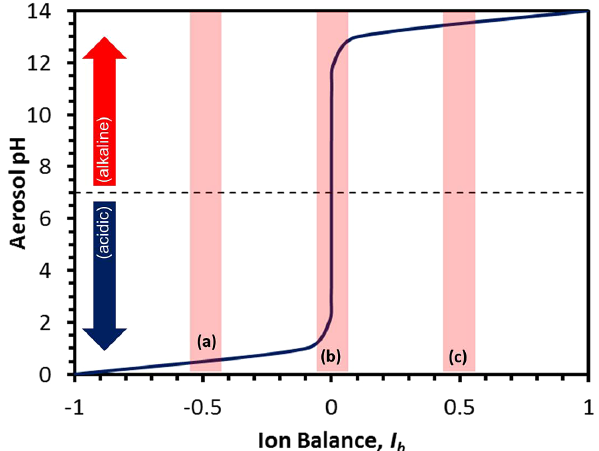
Figure 2. Aerosol pH as a function of the parameter I b (see Eq. 7 for explanation). The data used here are hypothetical: values of I b ranging from − 1 to 1 at a constant aerosol loading were input un- der conditions of constant T and RH to demonstrate the extreme sensitivity of aerosol pH at I b values near 0.0 (region b).